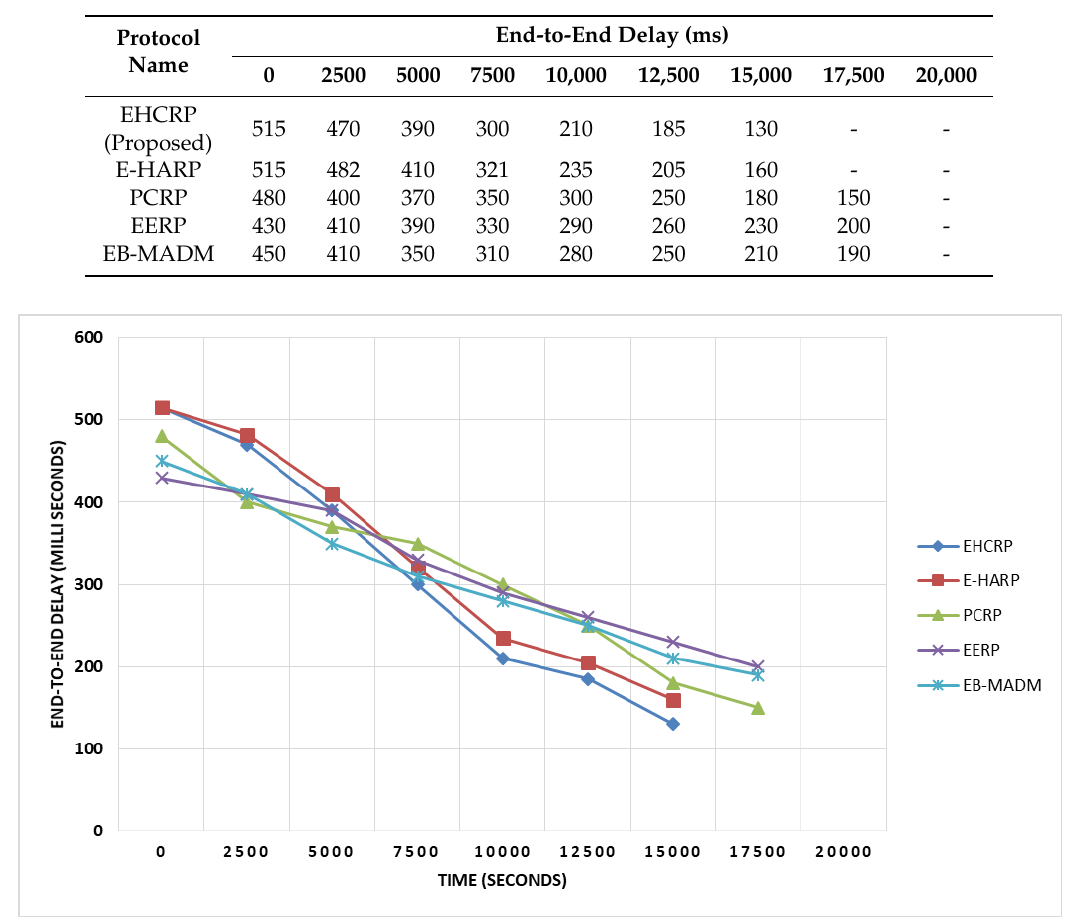
Table 8. End-to-End delay vs. time(s).